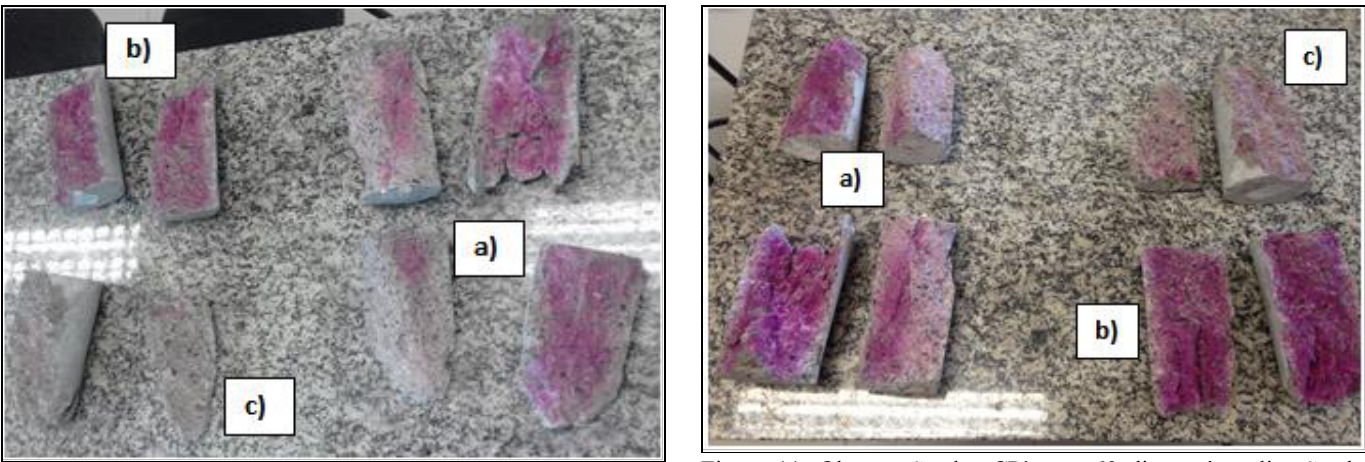
Figura 11: Observação dos CP’s aos 63 dias após aplicação do indicador químico de fenolftaleína. a)Traço com 0,0% de fibra; b)Traço com 0,5% de fibra; c)Traço com 1,0% de fibra.